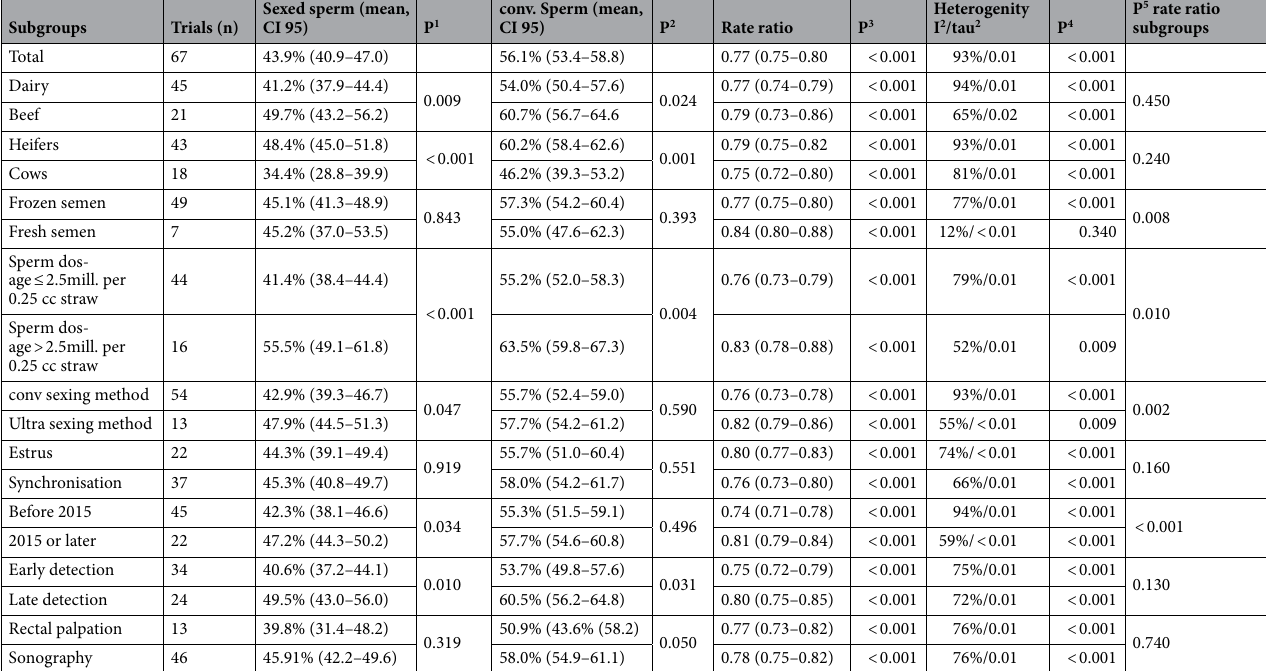
Table 2. Summary of the results of the meta-analysis of pregnancy rates after the use of sex-sorted and conventional sperm with a special focus on the effects of cow type, age, sperm freezing, sperm concentration, sperm sexing technology, timepoint of publication, and herd management. p: determination of statistical significances of: 1: the differences between two subgroups of cows inseminated with sex-sorted sperm using the t-test or Mann–Whitney U test. 2: the differences between two subgroups with conventional semen using the t-test or Mann–Whitney U test. 3: the determined rate ratio and odds ratio, respectively, using the Cochran–Mantel–Haenszel test (CMH). 4: the heterogeneity using the chi-square test. 5: the differences between subgroups inseminated with sex-sorted and conventional sperm using the